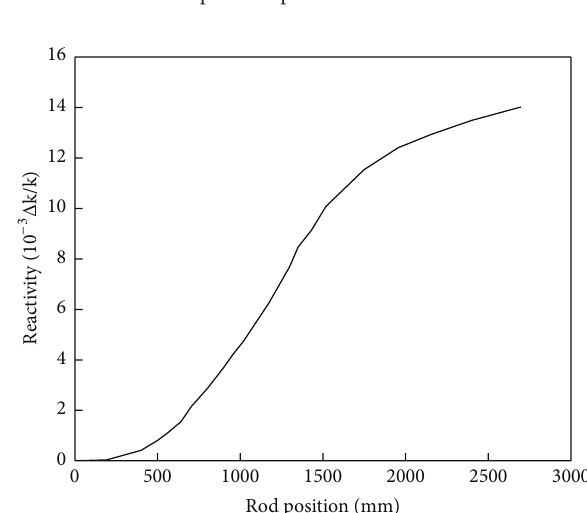
Figure 2: Operation parameters of the HTR-10.